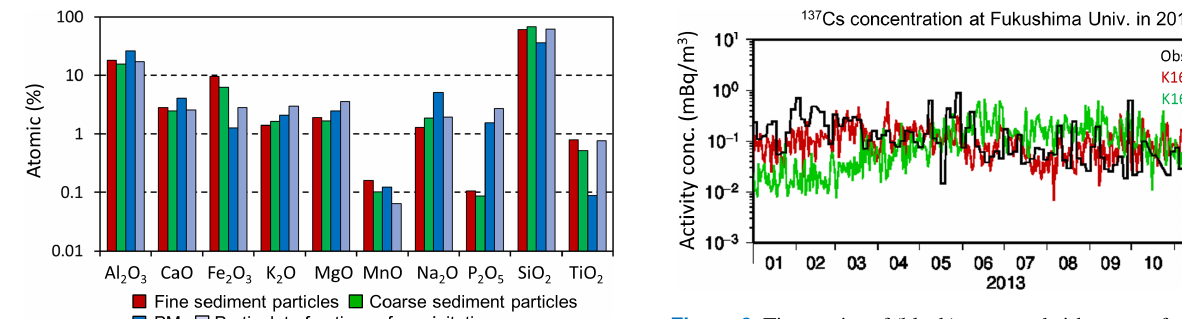
Figure 8. Time series of (black) measured airborne surface concen- trations of 137 Cs and those simulated (by Kajino et al., 2016; K16) considering different emission sources, mineral dust from bare soil (red) and aerosols emitted from forest ecosystems